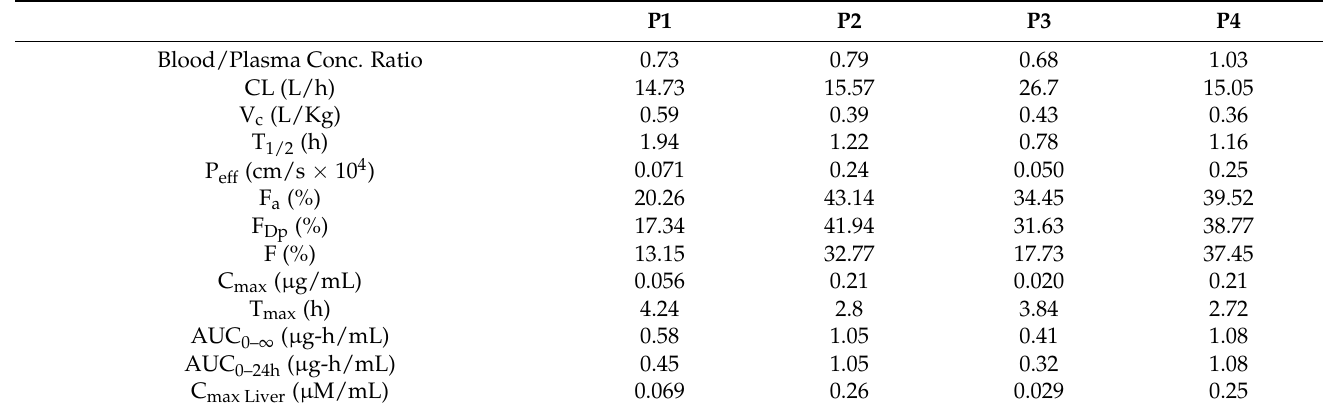
Table 2. Summary of simulated mean plasma PK parameters for GastroPlus ® simulation of P1–P4.